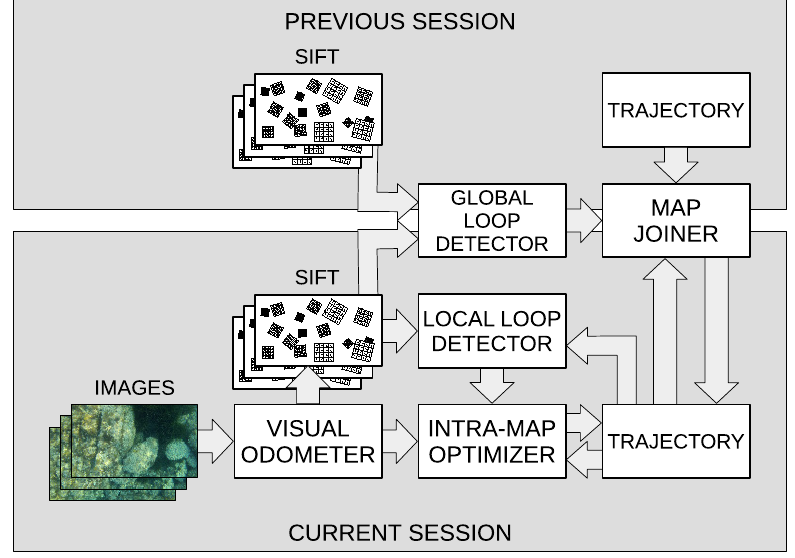
Figure 1. Sigle Session SLAM